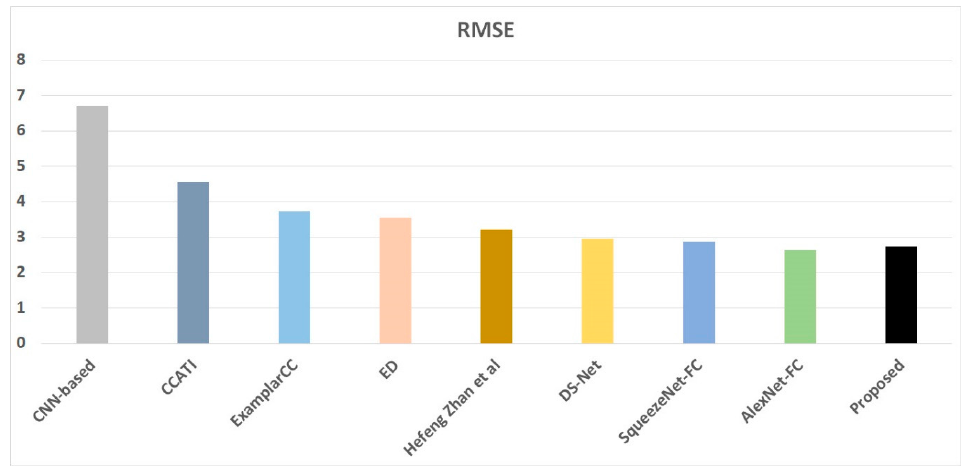
Figure 7. Comparison of root mean square error (RMSE) results of CNN-based, exemplar-based, ensemble of decision (ED) tree based methods, DS-Net, AlexNet-FC4, SqueezeNet-FC4, CCATI, Zhan et al., and the proposed network (proposed) with the angular error as input.